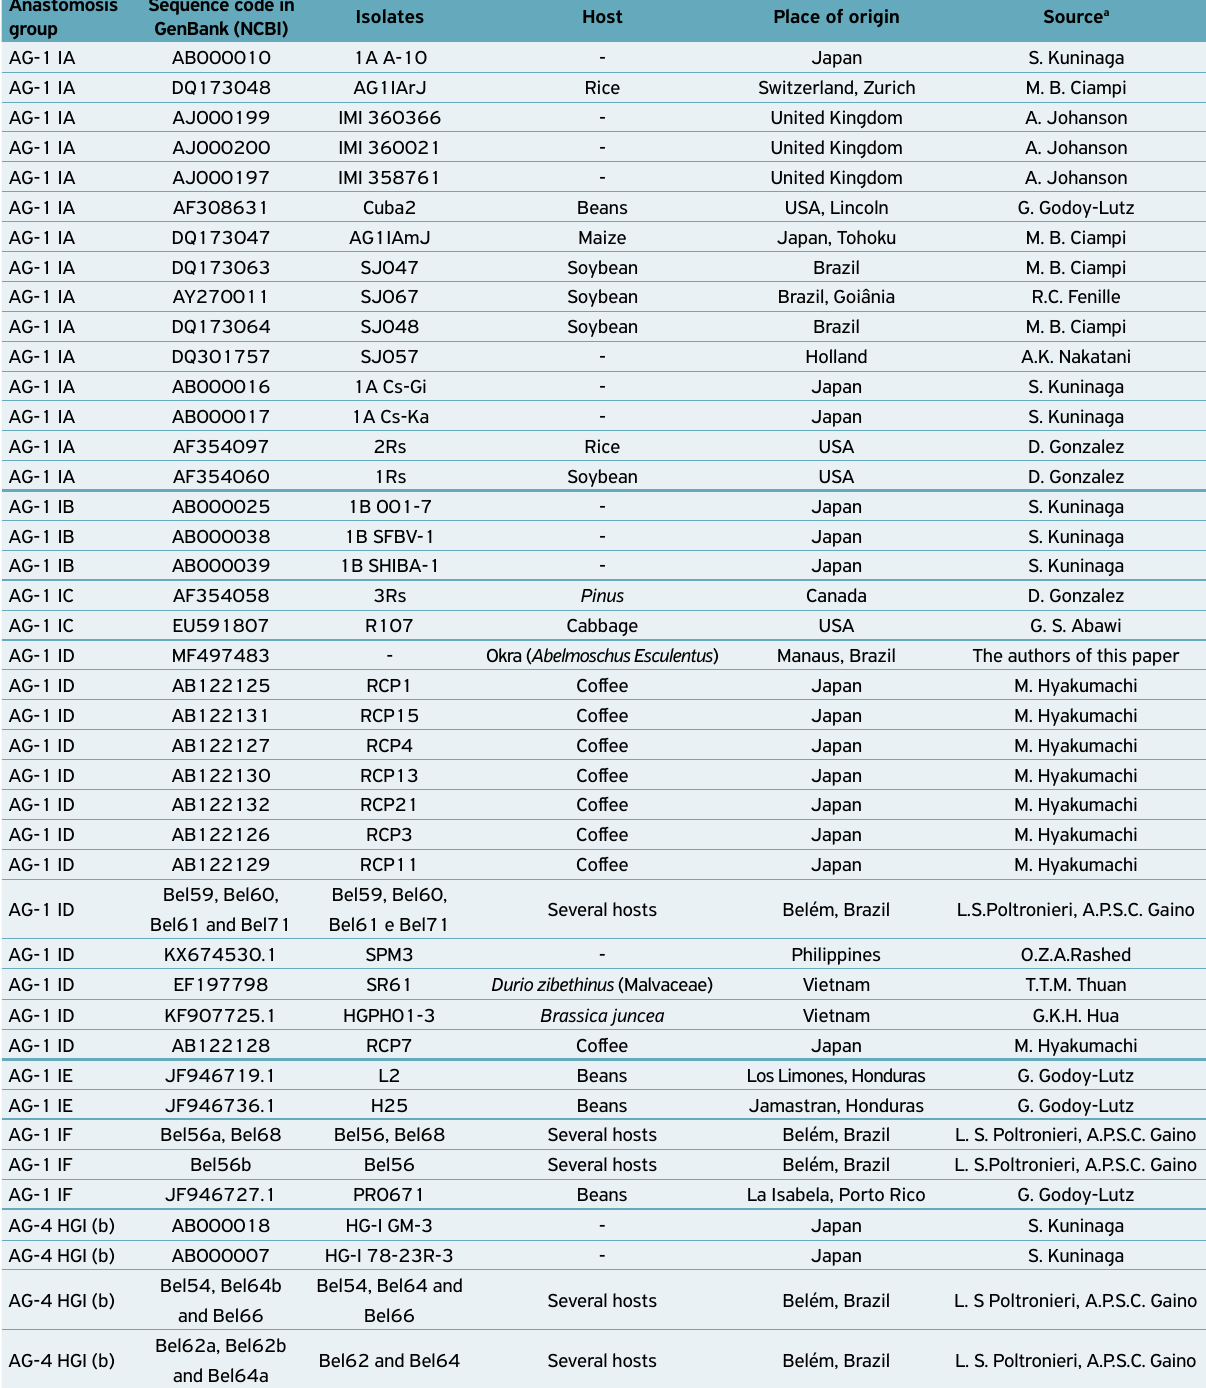
Table 1. DNA sequences of rDNA’s ITS1-5.8S-ITS2 region from standard isolates of AG-1 and AG-4 HGI complexes from Rhizoctonia solani that is used to determine the phylogenetic position of the pathogen’s isolate associated with web blight on okra. Anastomosis